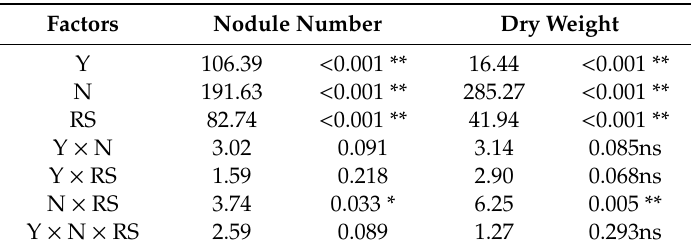
Table A2. Results of repeated measures ANOVA about e ff ects of year (Y), nitrogen levels (N), and root separation method (RS) on nodule number and dry weight of alfalfa.